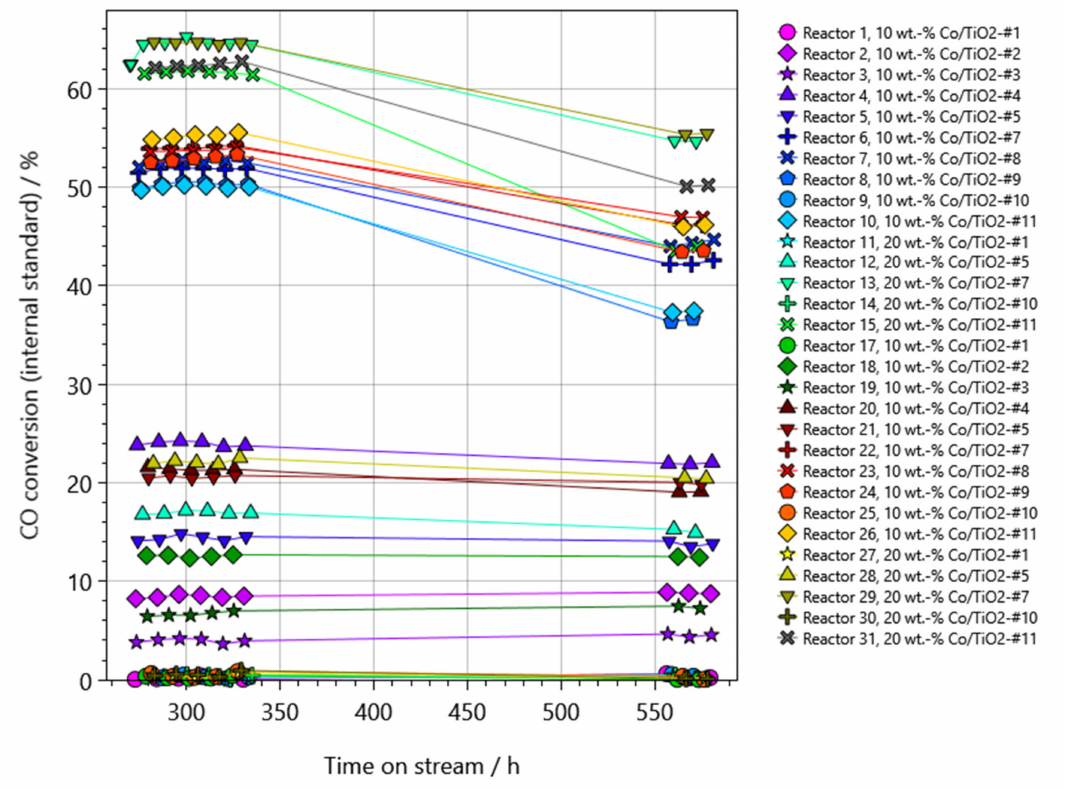
Figure 9. Catalyst deactivation after high severity